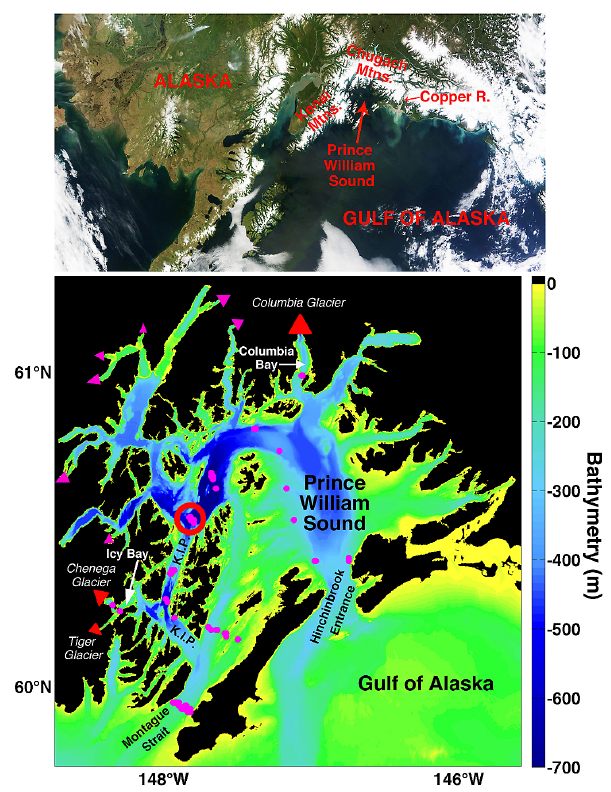
Fig. 1. Top panel is a Moderate Resolution Imaging Spec- troradiometer (MODIS) true color image of southern Alaska from spectral data collected aboard the National Aeronau- tics and Space Administration (NASA) Terra satellite on 16 June 2013. The image was provided by the NASA Earth Observatory (http://earthobservatory.nasa.gov/IOTD/view.php?id= 81416\&src=eoa-iotd), and shows a cloud-free day over southern Alaska with Prince William Sound (PWS) and the adjacent Gulf of Alaska (GOA) visible from space. Labeled geological features rel- evant to this study are the Chugach and Kenai mountain ranges on the north and west side of PWS, respectively, and the Copper River. Lower panel is bathymetry (color bar; m) of PWS with the locations of hydro-casts marked where dissolved inorganic carbon (DIC) and total alkalinity (TA) measurements were collected (magenta dots). Hinchinbrook Entrance and Montague Strait are labeled, as these are the major connections between PWS and the GOA. Knight Is- land Passage (K.I.P.) is the north–south oriented channel in the western portion of PWS. Icy Bay and Columbia Bay are marked because these fjords were sampled for the reason that they contain tidewater glaciers. The glaciers in these fjords are marked by red triangles, and other tidewater glaciers in PWS are marked by ma- genta triangles. Bathymetry data are from a digital elevation model (DEM) provided by the National Oceanic and Atmospheric Ad- ministration (NOAA) National Geophysical Data Center (NGDC; http://www.ngdc.noaa.gov/mgg/coastal/). The red circle delineates the single station (PWS2) that was sampled during every survey of PWS from 2009 through